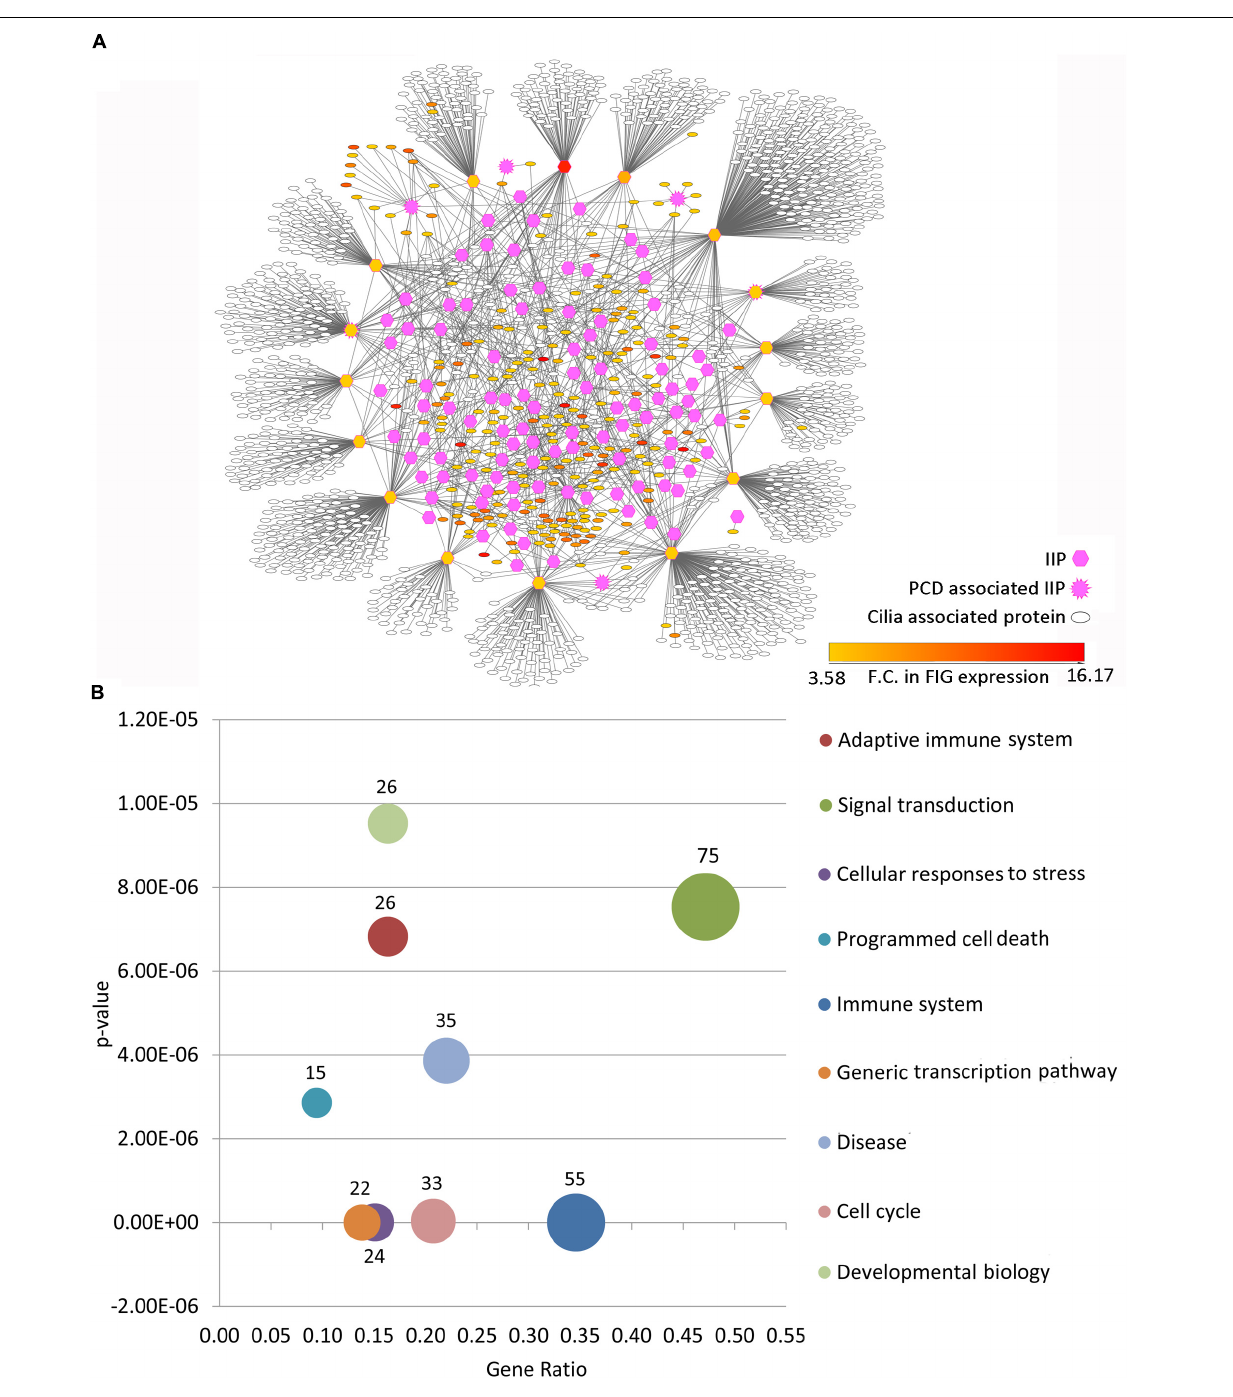
IIP-effector in the FOXJ1 regulatory network ( Table 2 ).